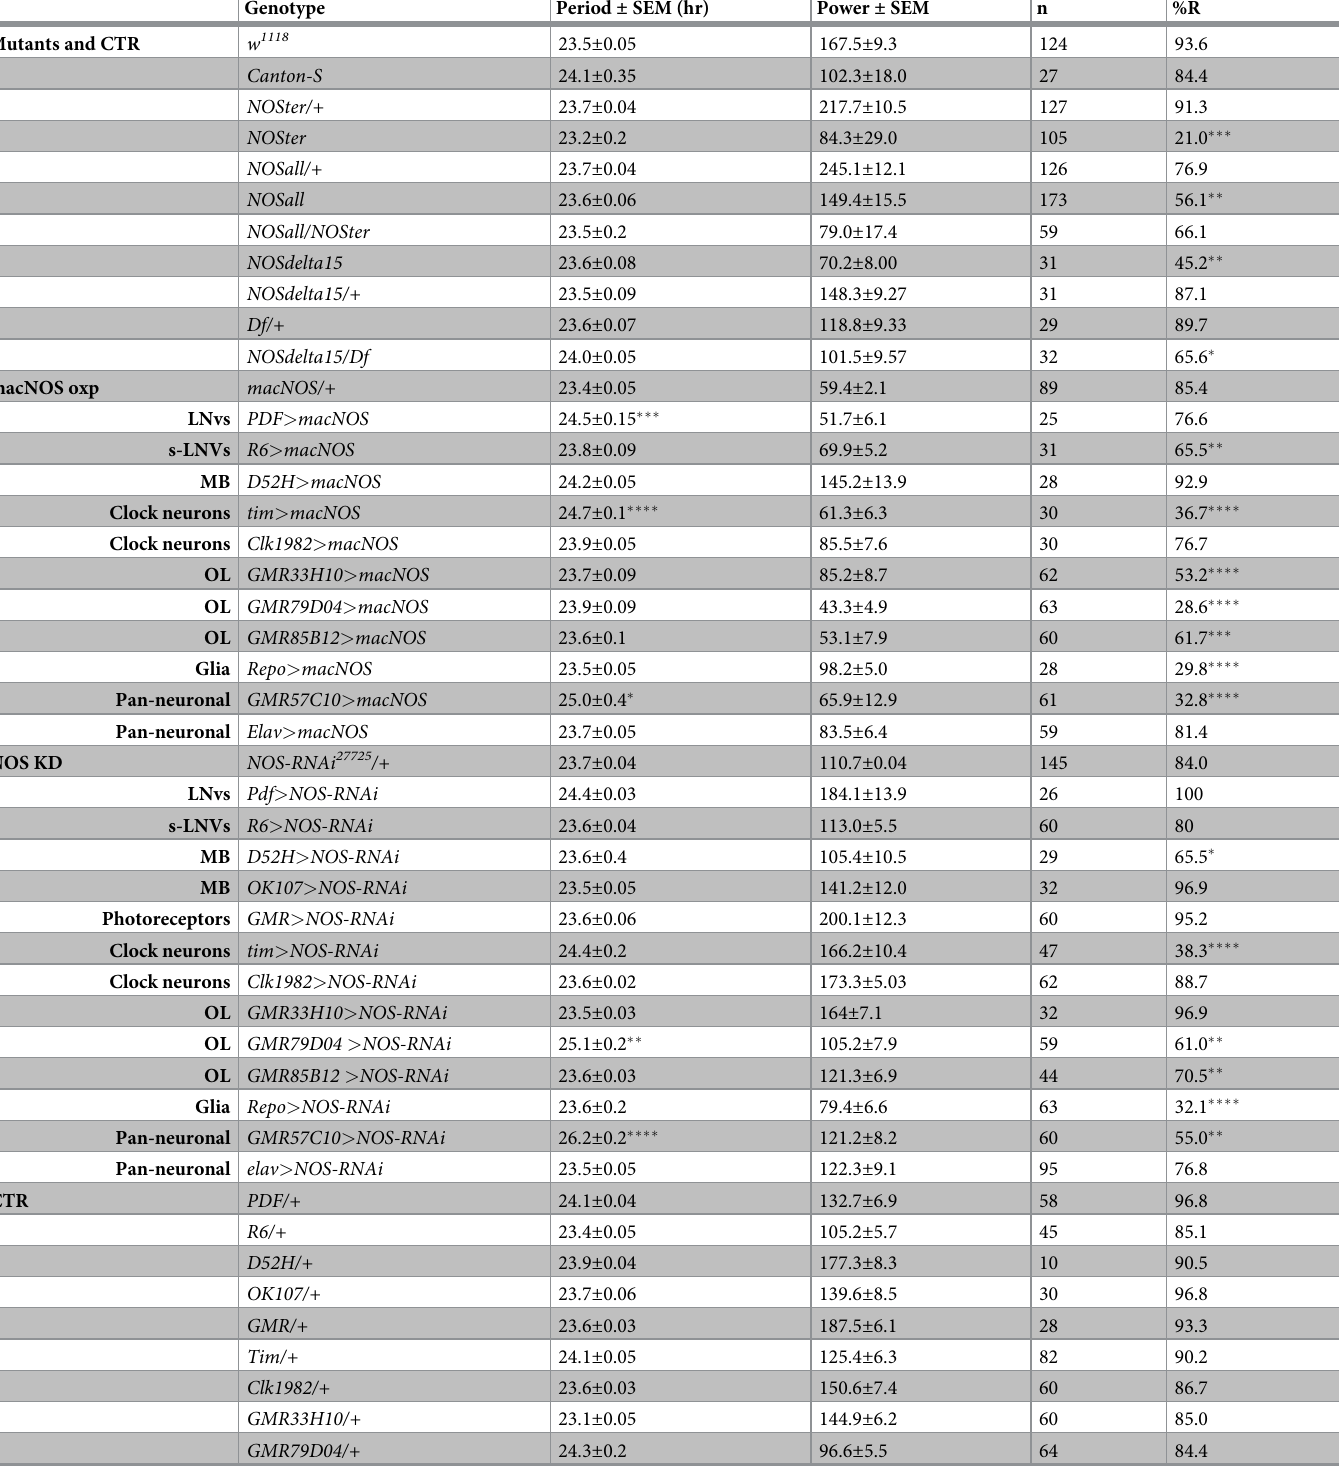
Table 1. Effects of NOS mutation, NOS knockdown, and macNOS overexpression on free-running locomotor rhythms. The left-most column explains the types of experiments and where the drivers are expressed. n , number of flies. %R, % of rhythmic flies. CTR, control. Oxp, over-expression. KD, knockdown. OP, optic lobes. Mean periods and rhythmicity of the test groups were compared with those of control groups using Student’s t-test and chi-square test, respectively. Mutants were compared with Canton-S and flies for knockdown and overexpression were compared with GAL4-only